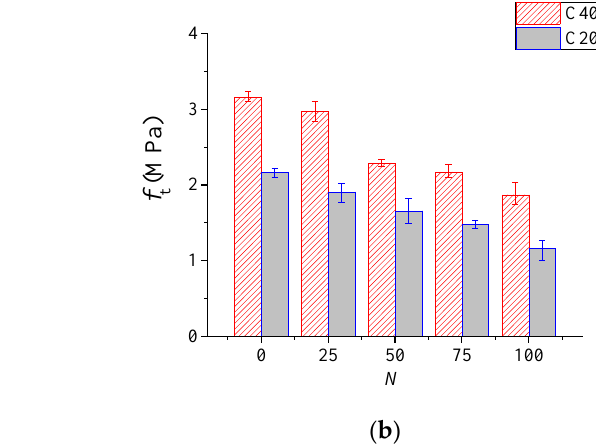
Figure 7. Relationship between ultimate bond strength and N .